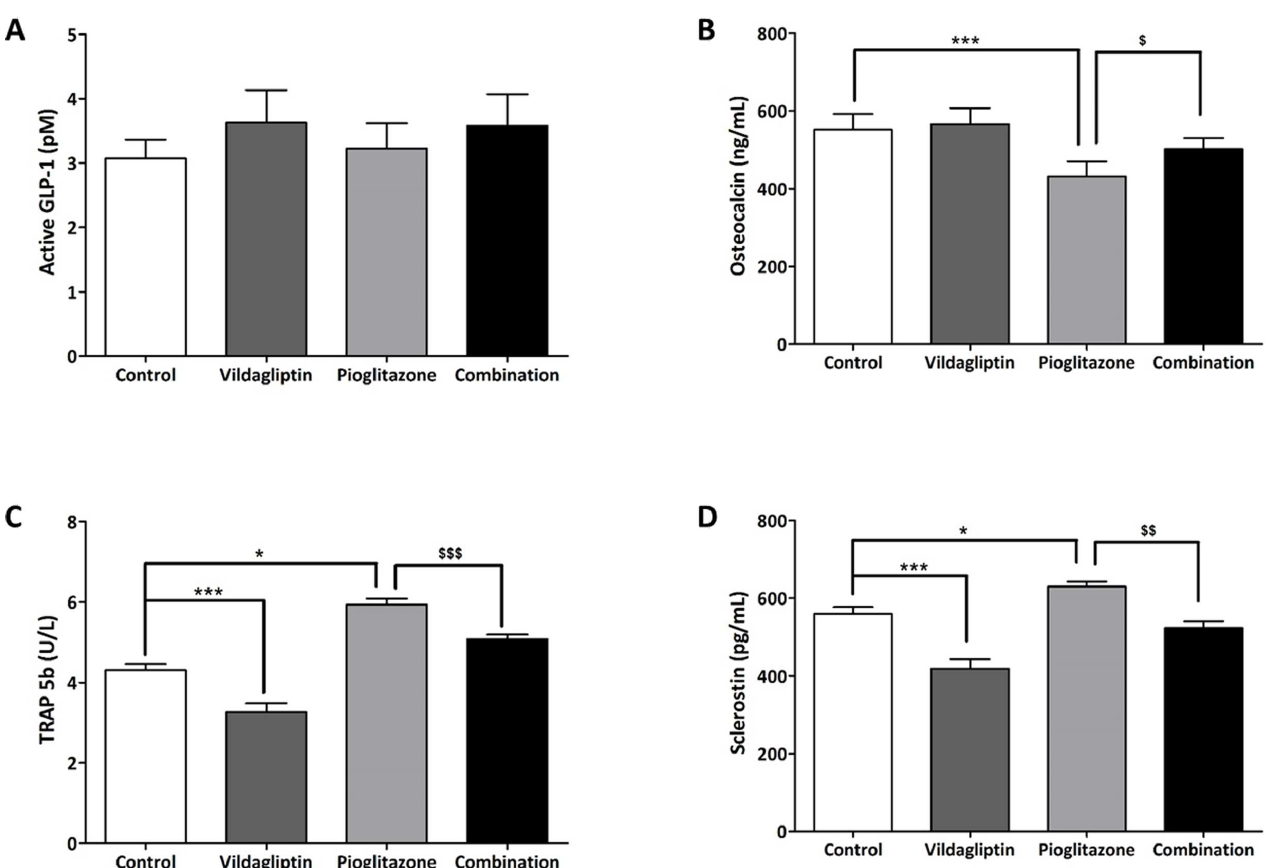
Fig 4. Active GLP-1, bone turnover markers(osteocalcin and TRAP 5b), and sclerostin levels in ZDF rats. (A) serum active GLP-1 levels, (B) serum osteocalcin levels, (C) serum TRAP5b levels, (D) serum sclerostinlevels. Blood samplingwas doneafter 5 weeks of treatment with control, vildagliptin (10 mg/kg/day), pioglitazone (30 mg/kg/day) and combination (vildagliptin 10 mg/kg/day and pioglitazone 30 mg/kg/day). And all data represented as Mean ± SD. * p < 0.05 *** , p < 0.001 comparedwith control group. $ p < 0.005, $$ p < 0.01, $$$ p < 0.0001versus pioglitazone group.